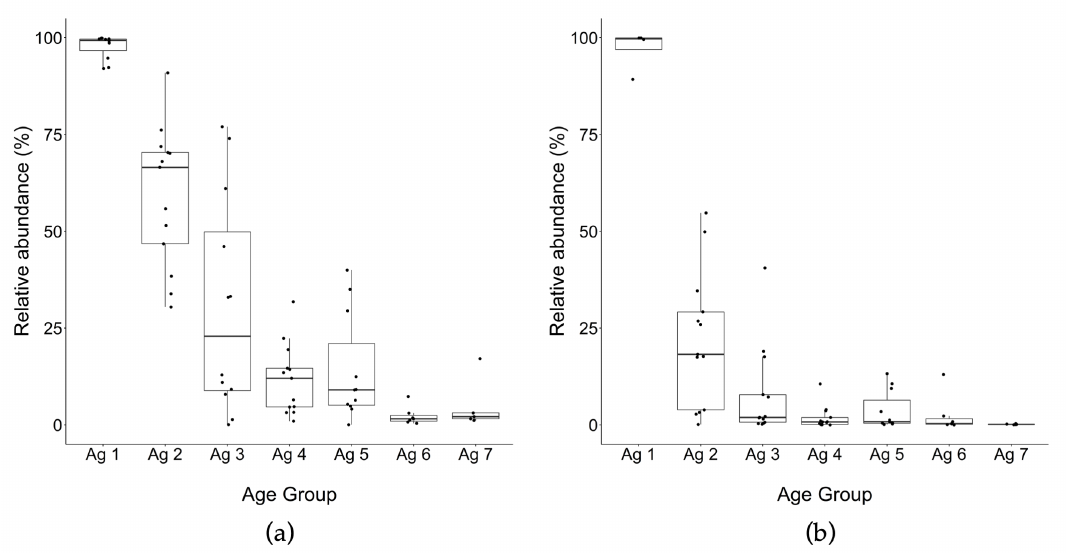
Figure 4. Box plot of relative abundance of Lactococcus spp. using OTU classification of 16S rRNA gene amplicon sequences for cheeses from trials 1 to 13 (% of total reads identified to genus level). ( a ) total DNA, ( b ) PMA-treated DNA. Ag 1: 0–1 m, Ag 2: 3–6 m, Ag 3: 7–10 m, Ag 4: 12–15 m, Ag 5: 18–20 m, Ag 6: 24, Ag 7: 30–32 m. Each box ranges from Q1 (the first quartile) to Q3 (the third quartile) of the data distribution and the range represents the IQR (interquartile range). The